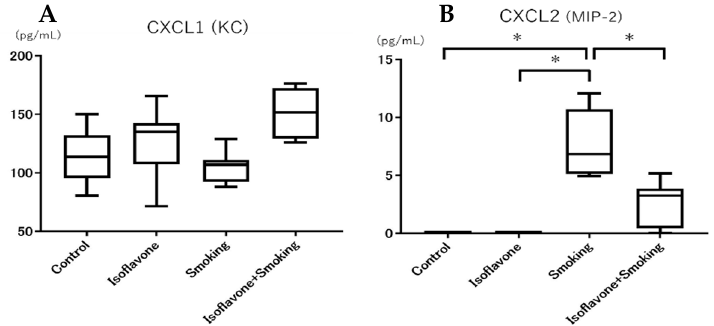
Figure 5. Protein level of CXCL1 (KC) and CXCL2 (MIP-2) in the BALF. ( A ) CXCL1 (KC) and ( B ) CXCL2 (MIP-2). Isoflavone significantly decreased the cigarette smoke-induced CXCL2 (MIP-2) level. Data are shown with box and whisker plots. * p < 0.05.